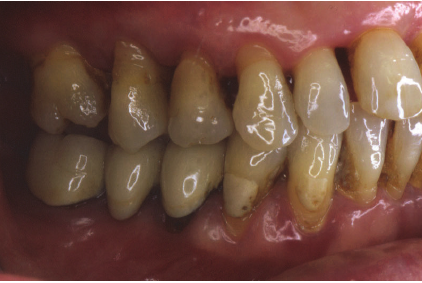
Figure 2: Initial case: lateral view, right side.